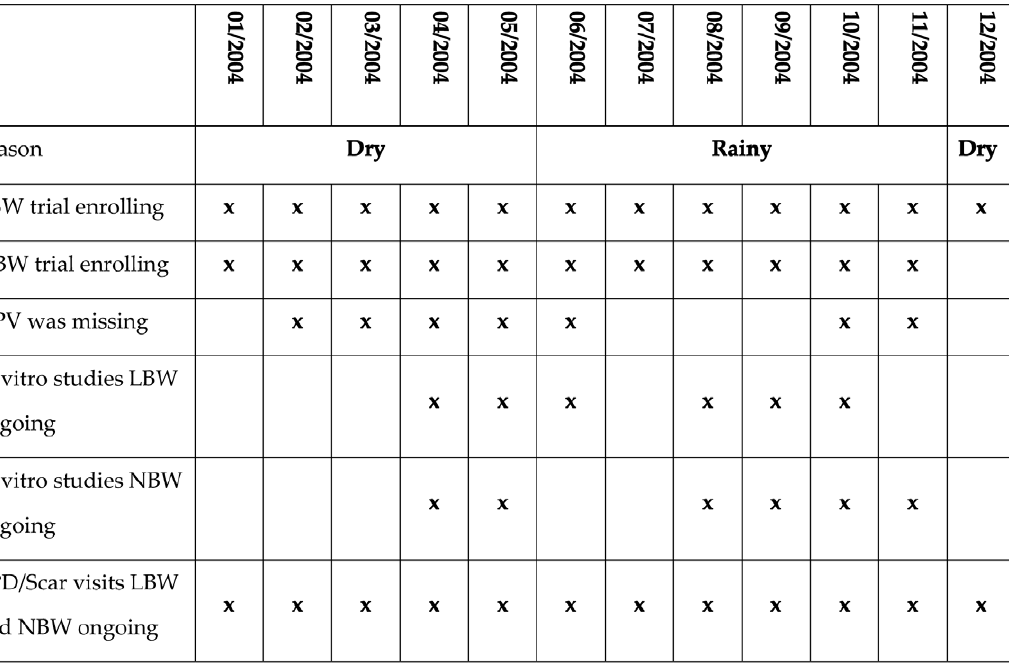
Figure 1. An overview of the two trials, the periods with missing OPV, and the periods with ongoing subgroup studies in Guinea- Bissau 2004.